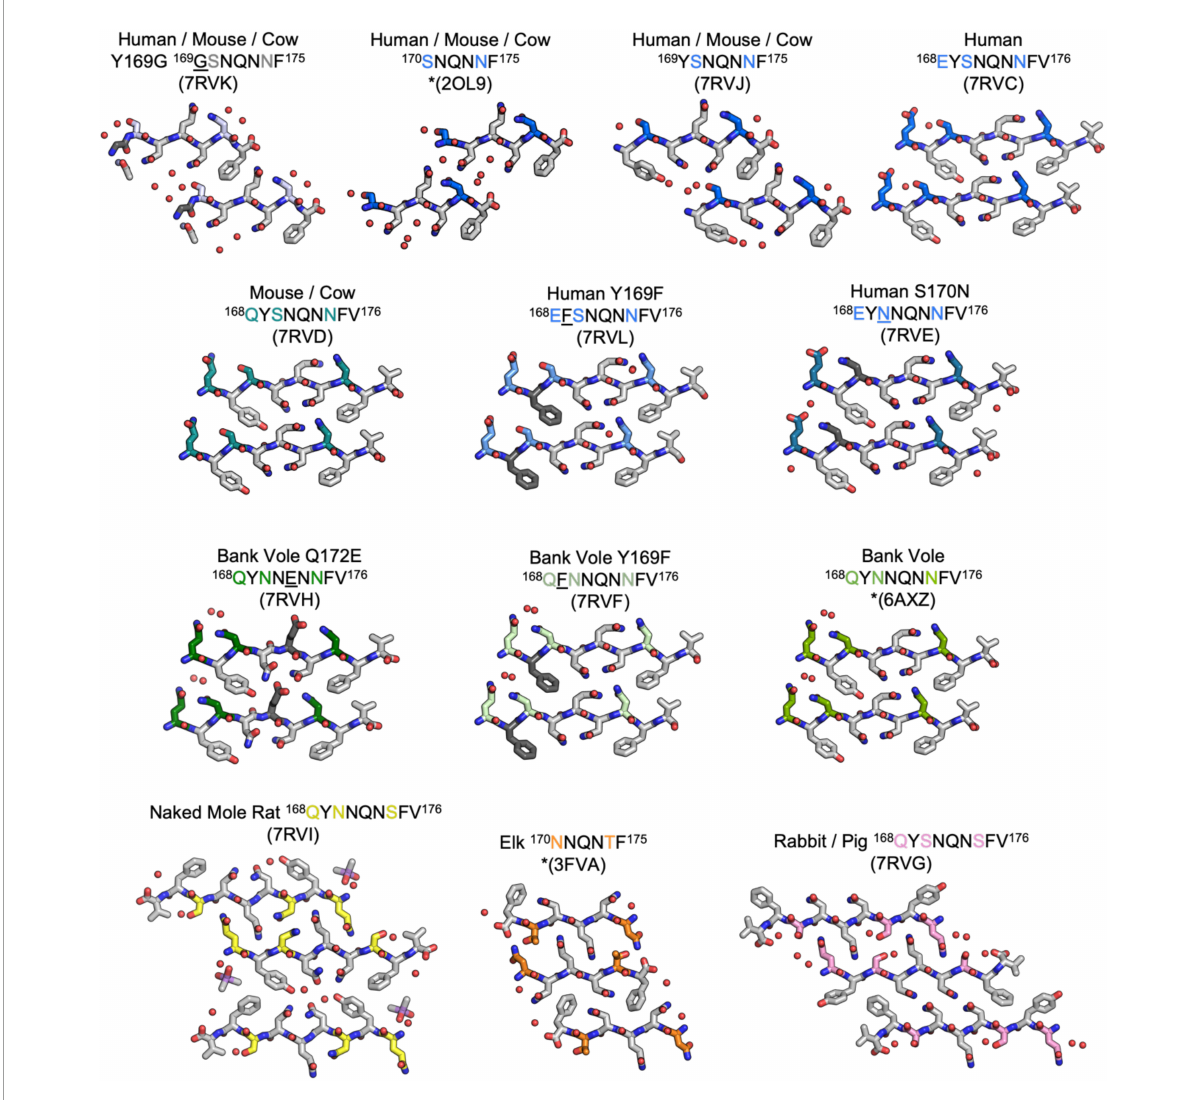
FIGURE2 Structures of crystalline mammalian prion β 2 α 2 loop aggregates. A single pair of strands is shown for each 9-residue segment to illustrate the interface between protofilaments. Additionally, three published structures from peptides SNQNNF (Sawaya et al., 2007), NNQNTF (Wiltzius et al., 2009), and QYNNQNNFV (Gallagher-Jones et al., 2018) (starred) are included for reference. All structures except for the bottom row are class 2 (face-to-back) steric zippers that fall into packing category 1. The bottom row is composed of class 1 (face-to-face) steric zippers that fall into packing category